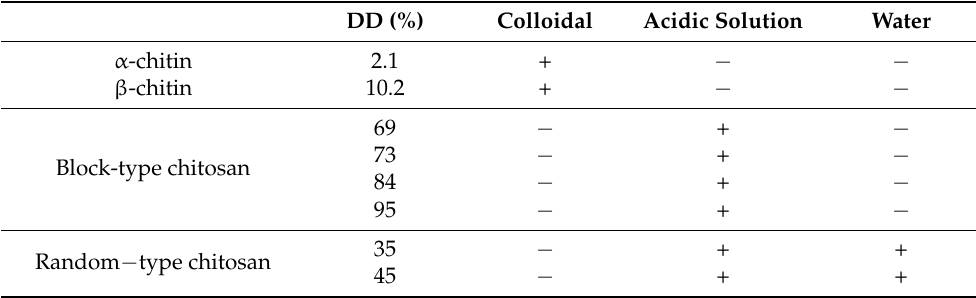
Table 1. Property of chitin and